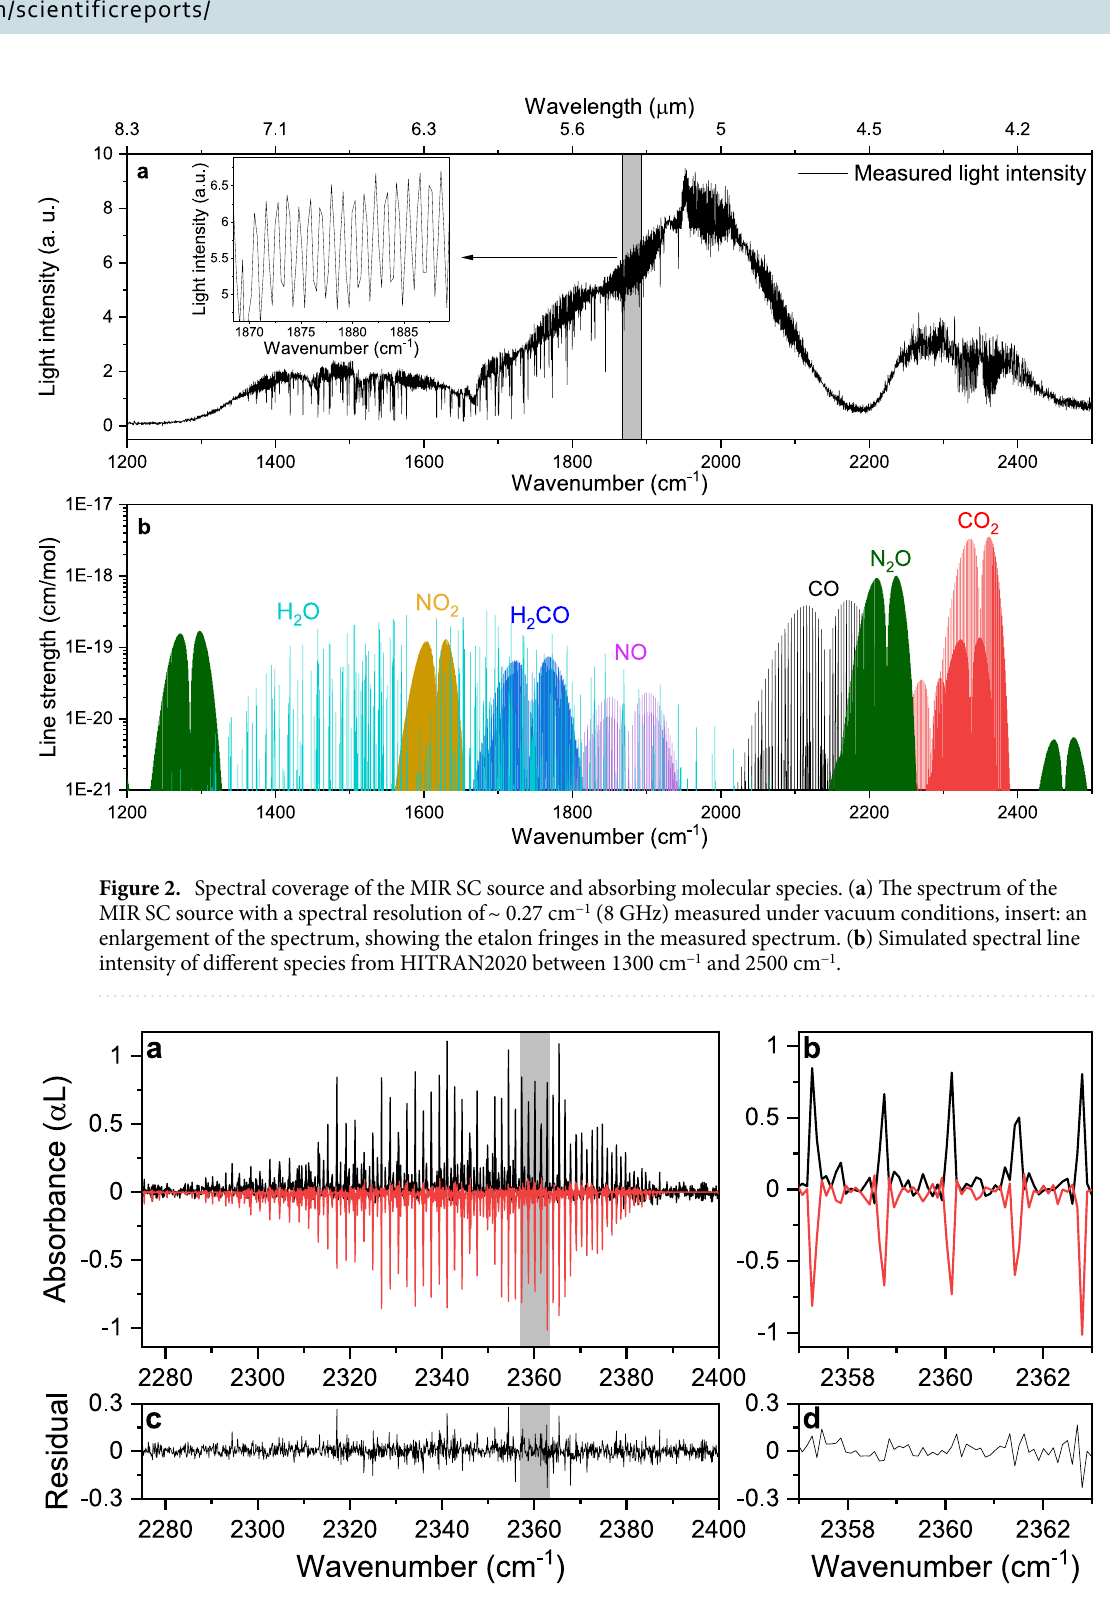
Figure 3. Experimental spectrum of CO 2 . ( a ) Measured spectrum (in black, 0.1 cm −1 spectral resolution, pressure 16.5 mbar, 500 averages in ~ 16 min) of 495 ppm CO 2 diluted in N 2 and a fitted modelled spectrum (in red, inverted) from the HITRAN database using a Voigt profile and convolved with a sinc-function. ( b ) Details of a part of the spectrum indicated in ( a ) as a grey rectangle. ( c , d ) Residual of the